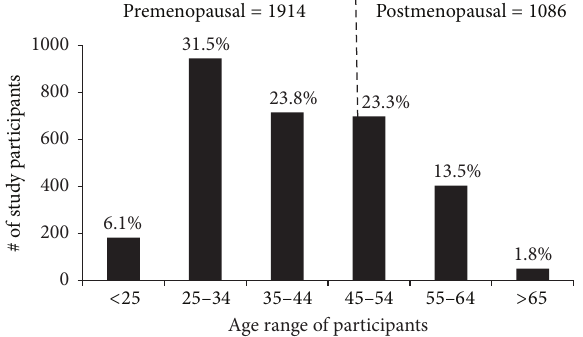
Figure 2: Pre- and postmenopausal classification of study partic- ipants. Study participants were categorized as premenopausal or postmenopausal based on the calculated menopause age of 46.6 years (broken line). Seventy-one (71) participants corresponding to 2.36% overall were within the 45–46.6-year group. The number of participants within each age group is shown in Table 1. Percentages shown for each age group were calculated as a fraction of partici- pants within that group over the total participants recruited.